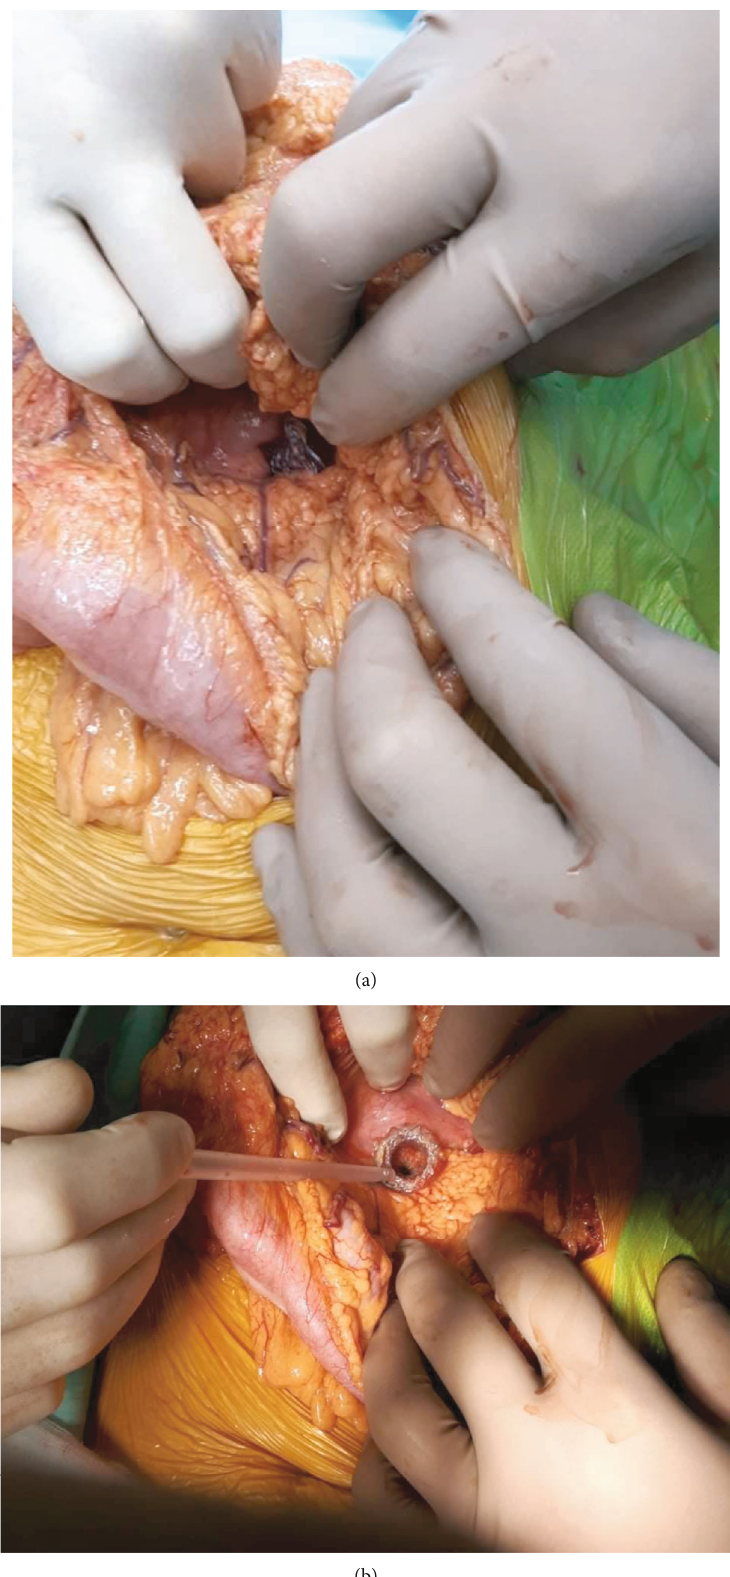
Figure 15: (a, b) Intraoperative image of a laparotomy performed in a patient su ff ering from early proximal dislocation of the transmural stent. The dislodged stent can be